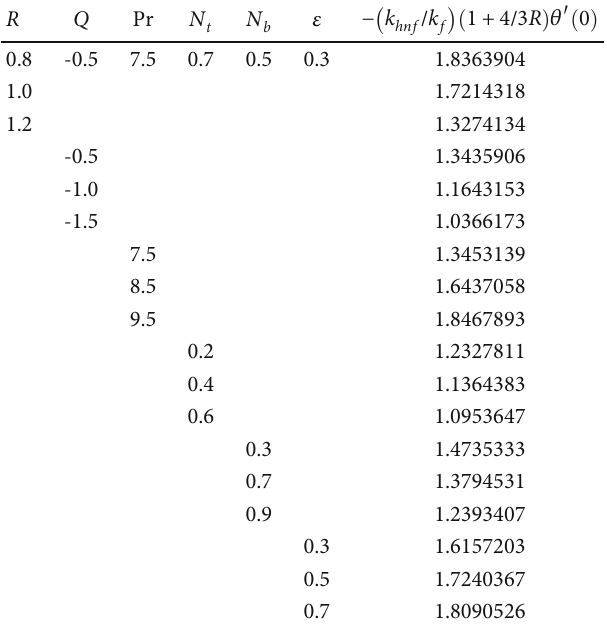
Table 5: Illustration of the in fl uence of di ff erent physical factors